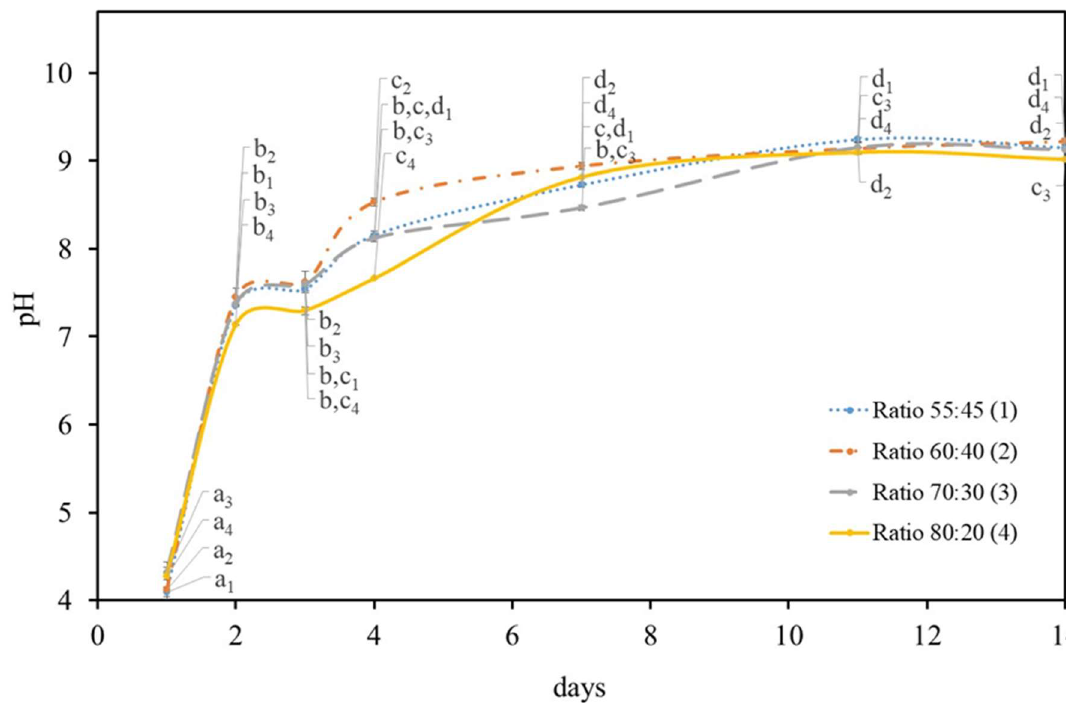
Figure 1. pH variation in the different HS:BG-11 ratio media during the 14 days of incubation of K. saccharivorans at 30 °C. Values in the same curve that do not share a common letter (index according to each HS:BG-11 ratio) are statistically different ( p < 0.05).